Question: Based on the figure, does the quantity rise or fall?
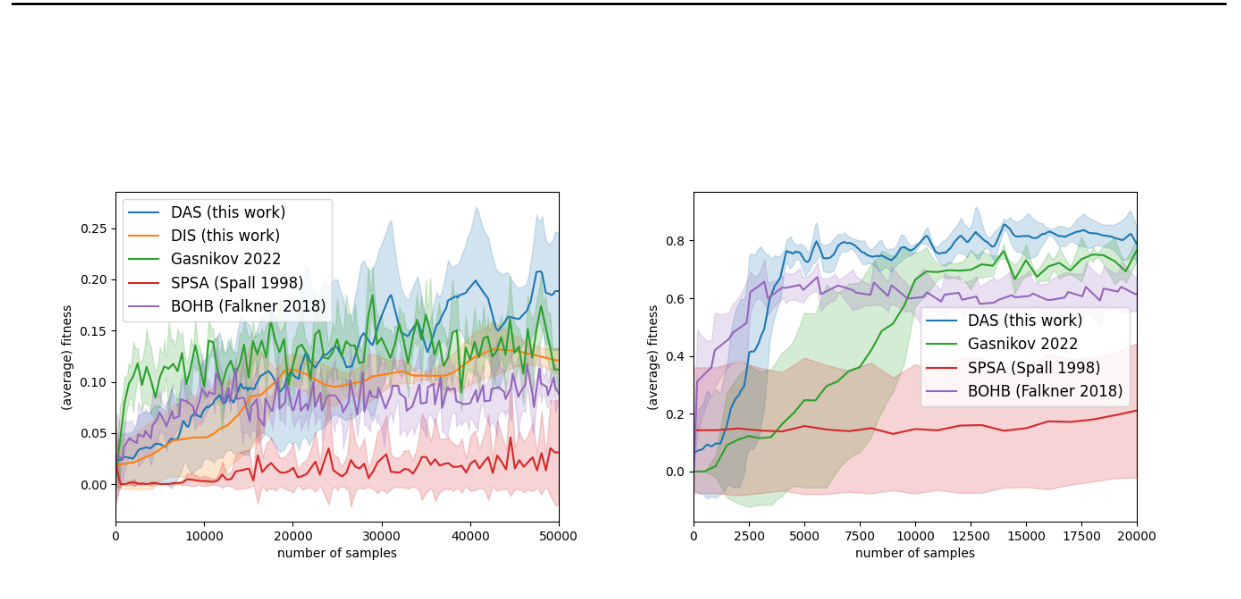
Answer: increasing